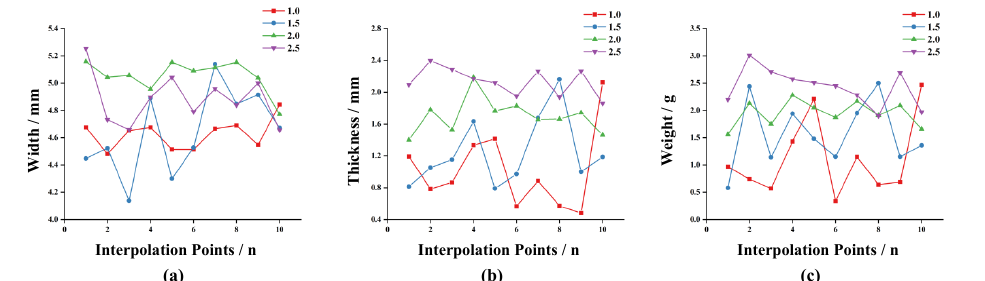
Figure 14. The results of the chip measurements. ( a ) Width measurement. ( b ) Thickness measurement. ( c ) Weight measurement.